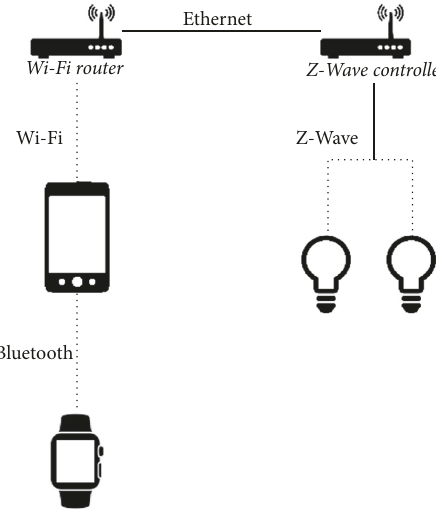
Figure 3: A simple setup with two connected Z-Wave lamps.